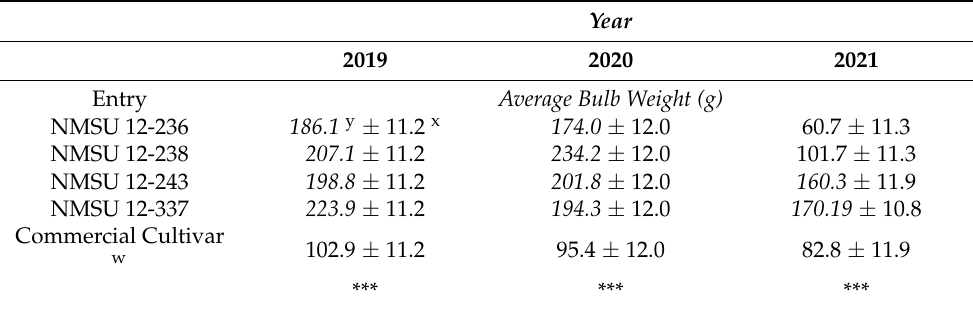
Table 4. Average bulb weight measured upon harvest on per plant basis for five onion entries grown at the Fabian Garcia Science Center and Leyendecker Plant Science Research Center, Las Cruces, NM, during the 2019, 2020 and 2021 growing seasons z